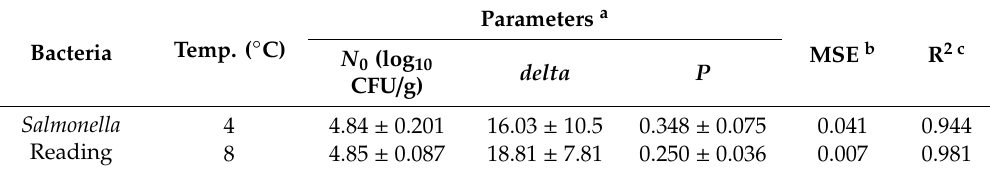
Table 3. Estimated parameters for the survival kinetic model of